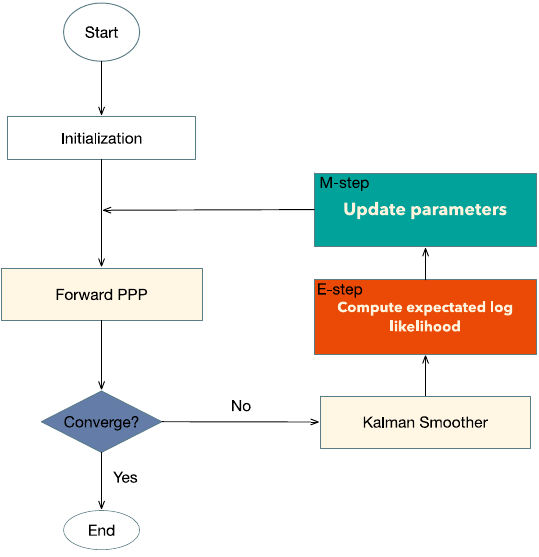
Figure 1. Flowchart of the Expectation-Maximization (EM)-Precise Point Positioning (PPP) loop.